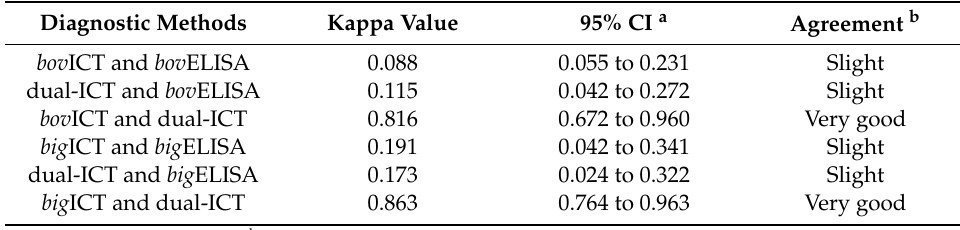
Table 3. Agreement between ICT and